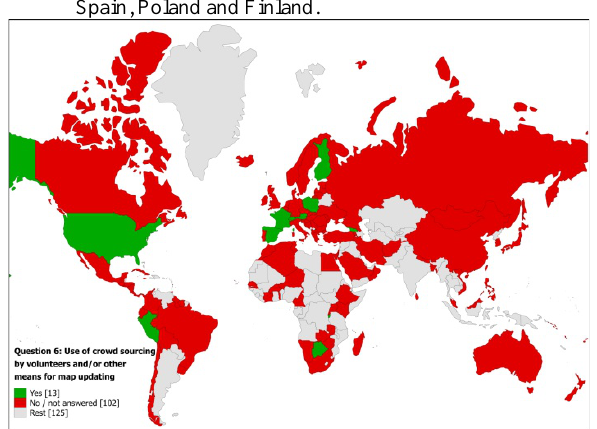
Figure 9: Question 6. Use of crowd sourcing for national data revision and map updating